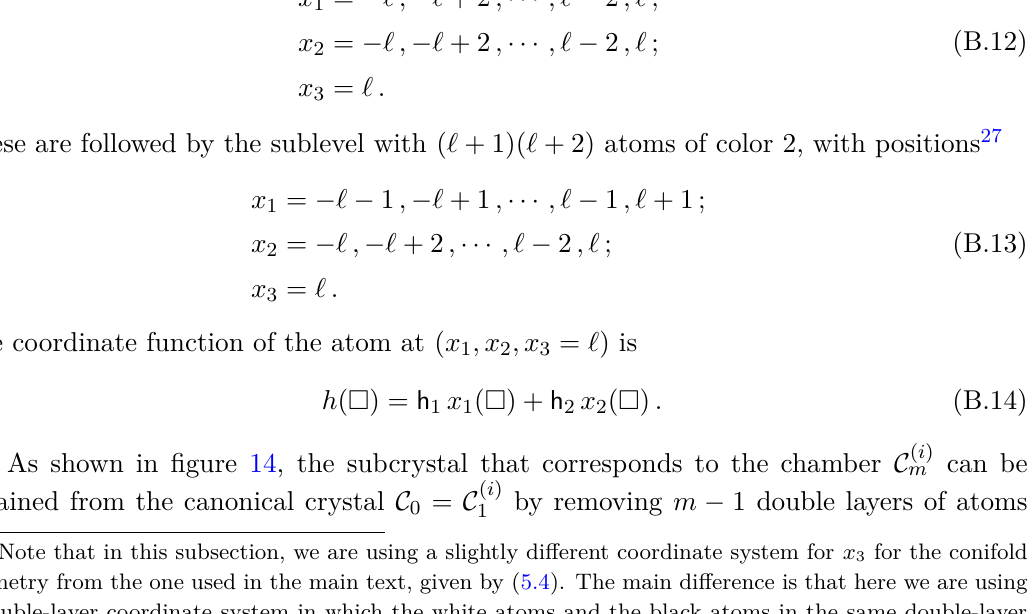
with two double 0 with m = 3 m